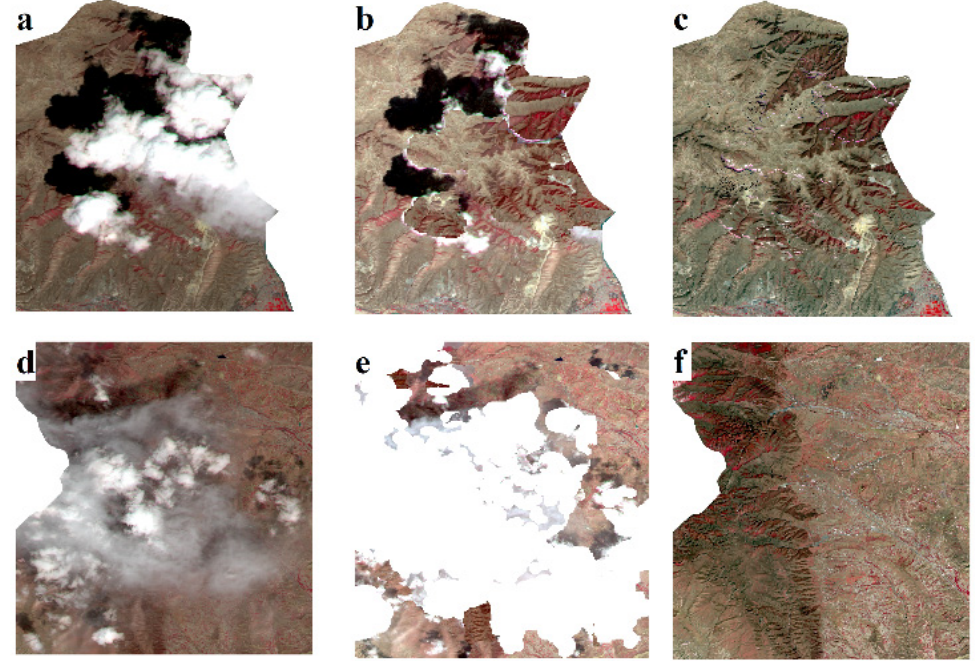
Figure 9. Phase 24: 22 April 2020 to 2 May 2020 composite: ( a , d ) are clouded areas in the original Sentinel images, ( b , e ) depict the Sentinel 2 de-clouding function built into GEE, and ( c , f ) are the mosaic cloud removal method employed in the present study.